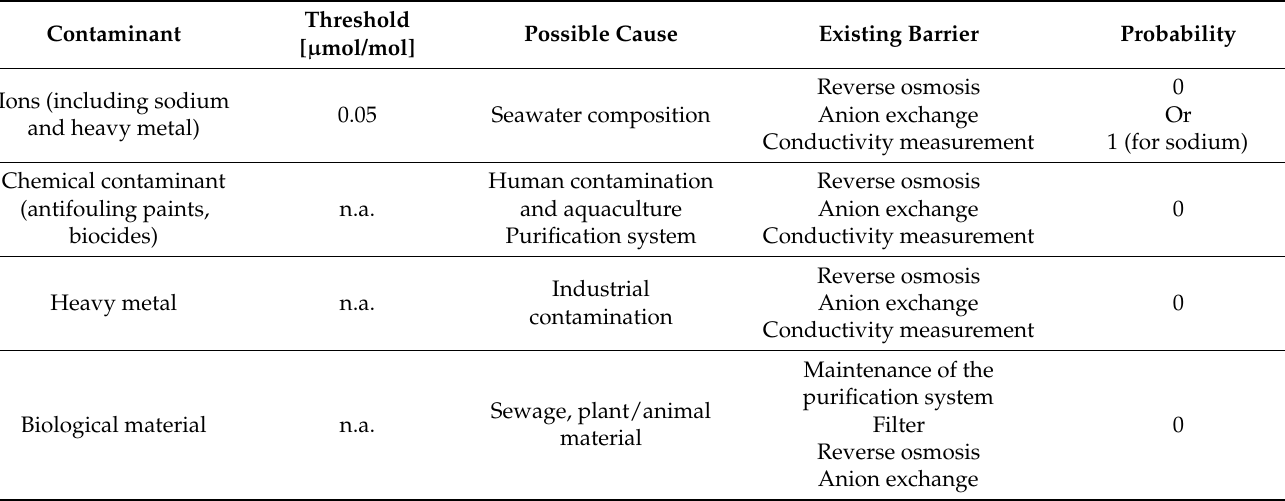
Table 3. Probability of occurrence of seawater contaminants in the hydrogen produced from onboard electrolyser using purified